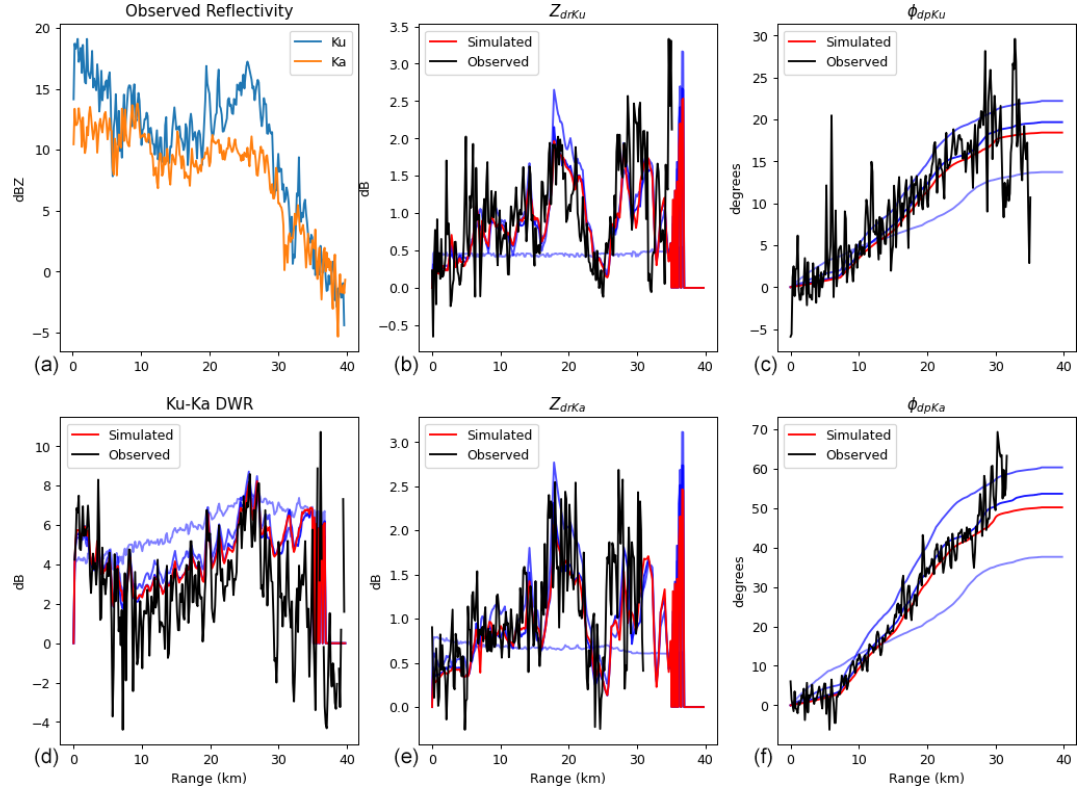
Figure 5. D3R observations of reflectivity (a) and DWR (d) , Z dr (b, e) , and φ dp (c, f) along the 231 ◦ azimuth, 6 ◦ elevation radial at 02:17UTC on 8 March 2018. For the DWR, Z dr , and φ dp , the D3R observations are indicated by the solid black lines and the simulated measurements for each iteration are shown in progressively more opaque blue lines, with the final iteration plotted in